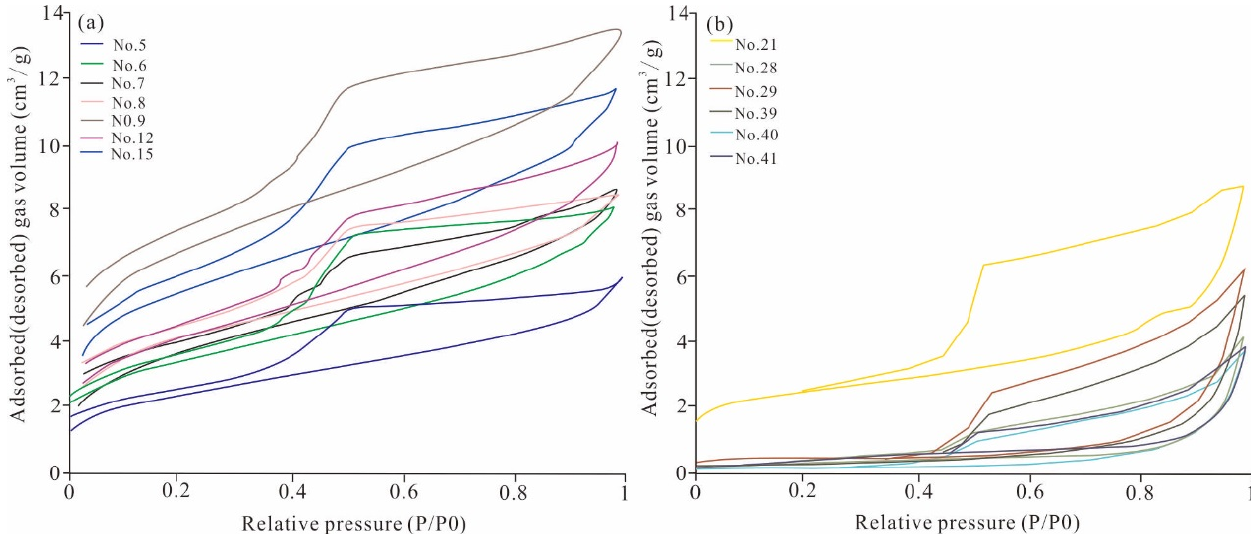
Figure 7. Pore shapes of the Silurian Longmaxi marine-shale samples ( a ) and the Lower Jurassic Dongyuemiao lacustrine-shale samples ( b ). Table 1. Parameters of pore structures of the Silurian Longmaxi marine-shale samples (a) and the Lower Jurassic Dongyuemiao lacustrine-shale samples from the Sichuan